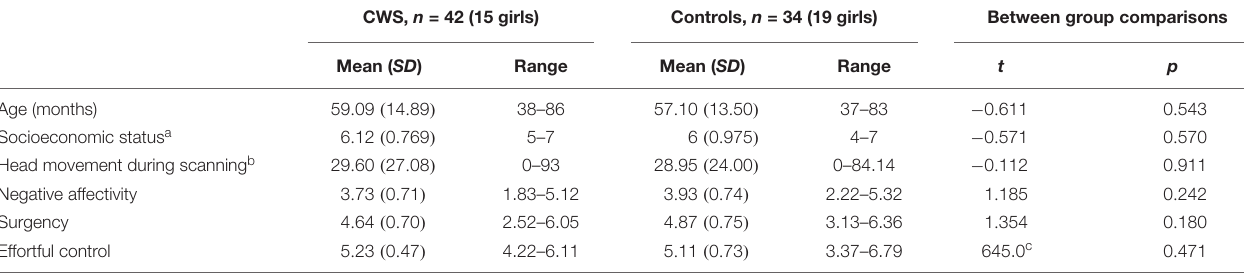
TABLE 1 | Demographic information of children who stutter (CWS) and controls included in this